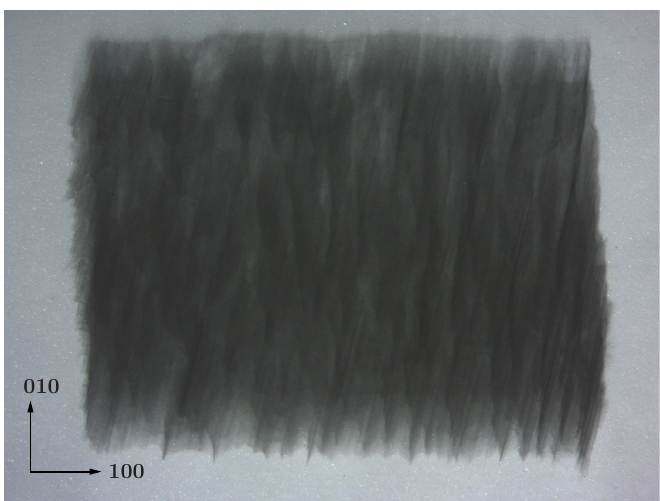
Figure A1. A white-beam topograph obtained in transmission (Laue) geometry from 131 reflection of plate CVD-B. Individual dislocations are not easily discerned, which confirms high dislocaiton density